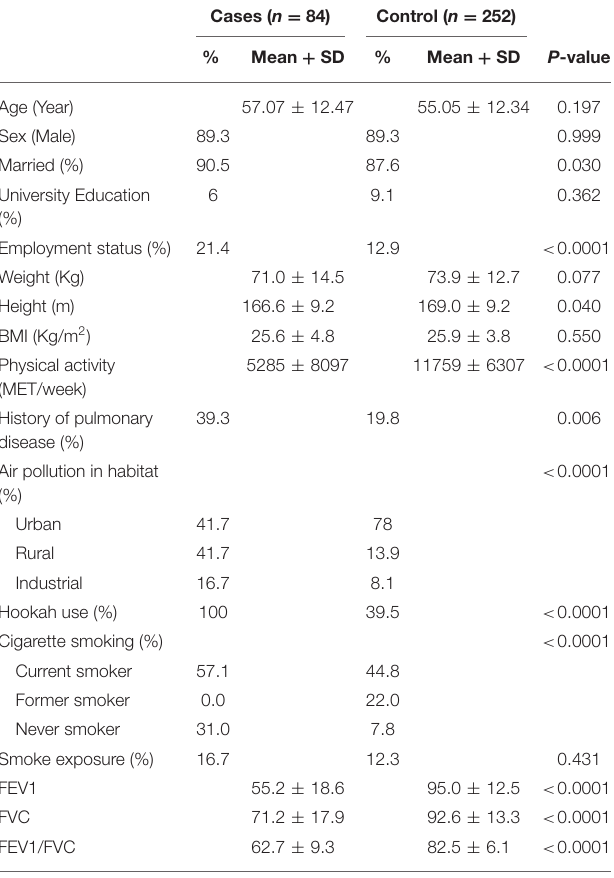
TABLE 1 | Characteristics of patients with COPD and control